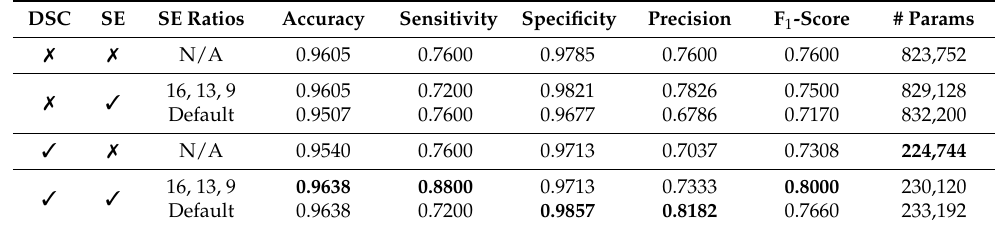
Table 3. Ablation study on the A-DSSS dataset. The default SE ratio is 16 for each attention block.